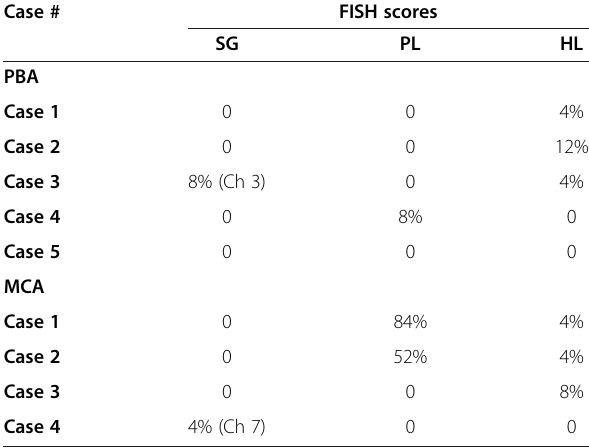
Table 6 Results of FISH using UroVysion probe set Case # FISH